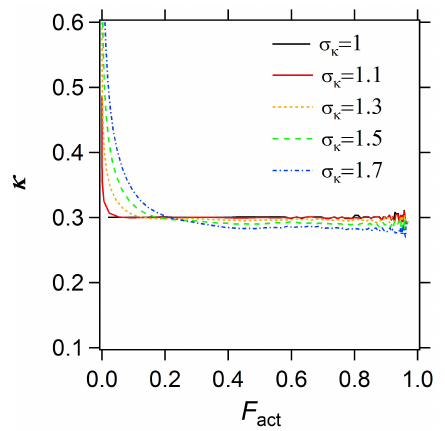
Figure 4. Influence of aerosol hygroscopicity ( κ) distribution on the retrieval of κ by BS2-CCNC. σ κ represents the geometric standard deviation of the aerosol hygroscopicity ( κ)